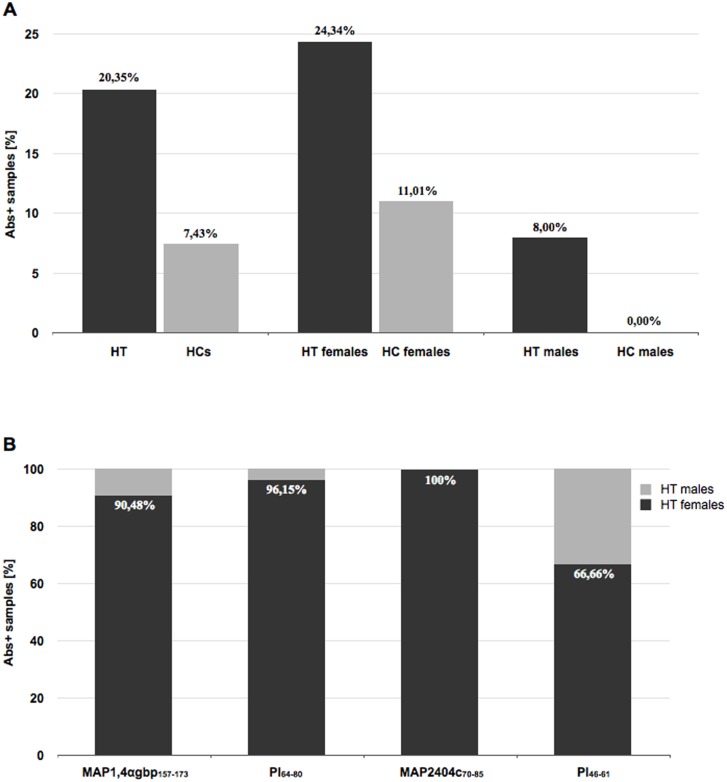
Prevalence of serum Ab positivity to MAP1,4αgbp157-173/PI64-80 and MAP2404c70-85/PI46-61 homologus epitopes in Sardinian HT patients and age/sex-matched HCs.